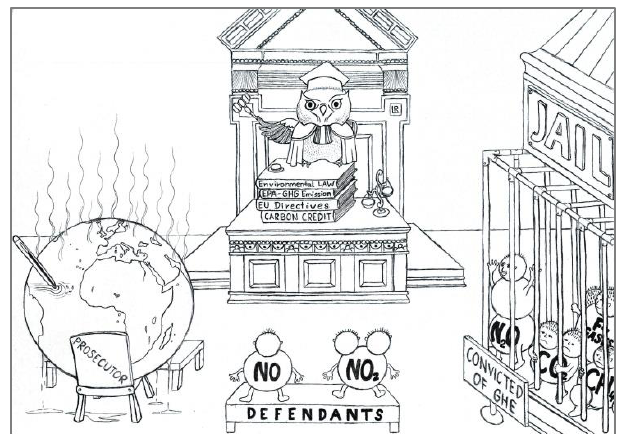
Figure 1. NOx as defendants in court (permission obtained from the author, © Radoslaw Lajnert). Figure 1. NO x as defendants in court (permission obtained from the author, © Radoslaw